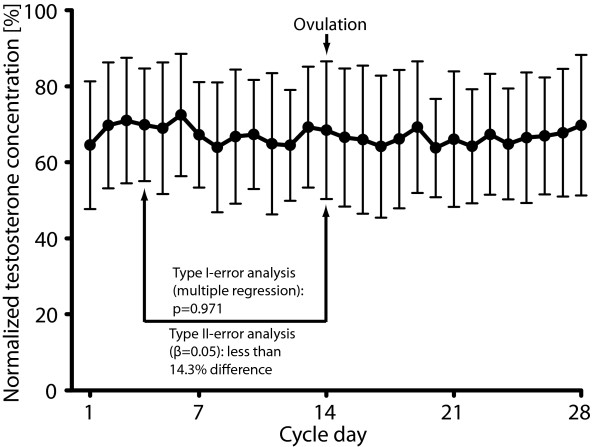
No effects of ovulation on testosterone concentrations. Normalized testosterone concentrations in the saliva from the males in the 29 included couples (one couple was excluded because of difficulties in determining the ovulation date). Bars for standard deviation on the Y-axis are depicted against cycle day on the X-axis. No difference could be seen between day 4 and 14 in the multiple regression analysis (p < 0.971), and an estimation of similarity by type II error(β)-analysis using pairwise power calculation showed that the difference between these two points was less than 14.3% (β = 0.05).